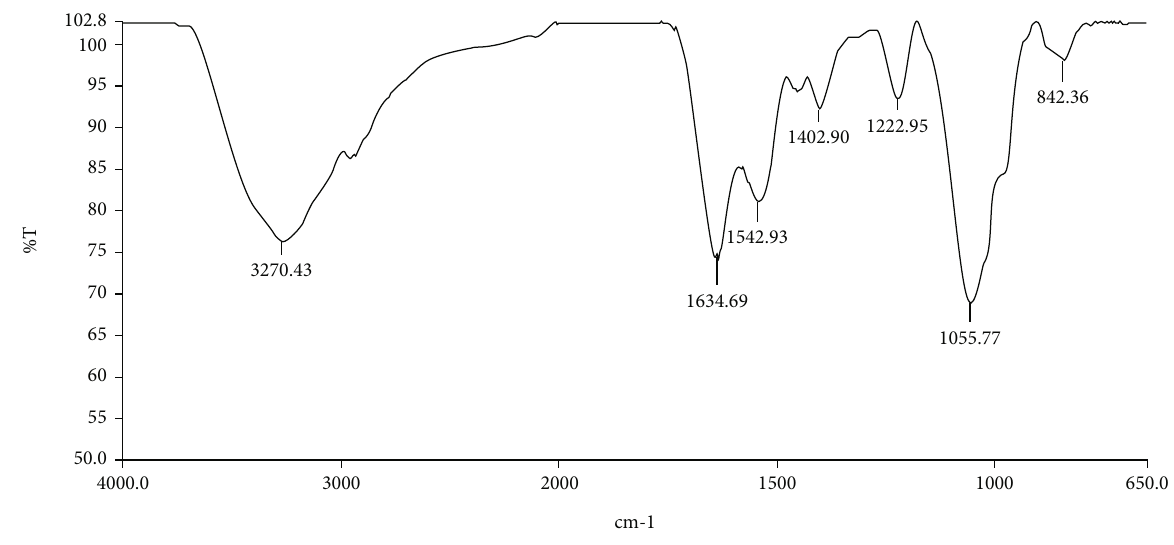
Figure 5: FT-IR analysis of VN5